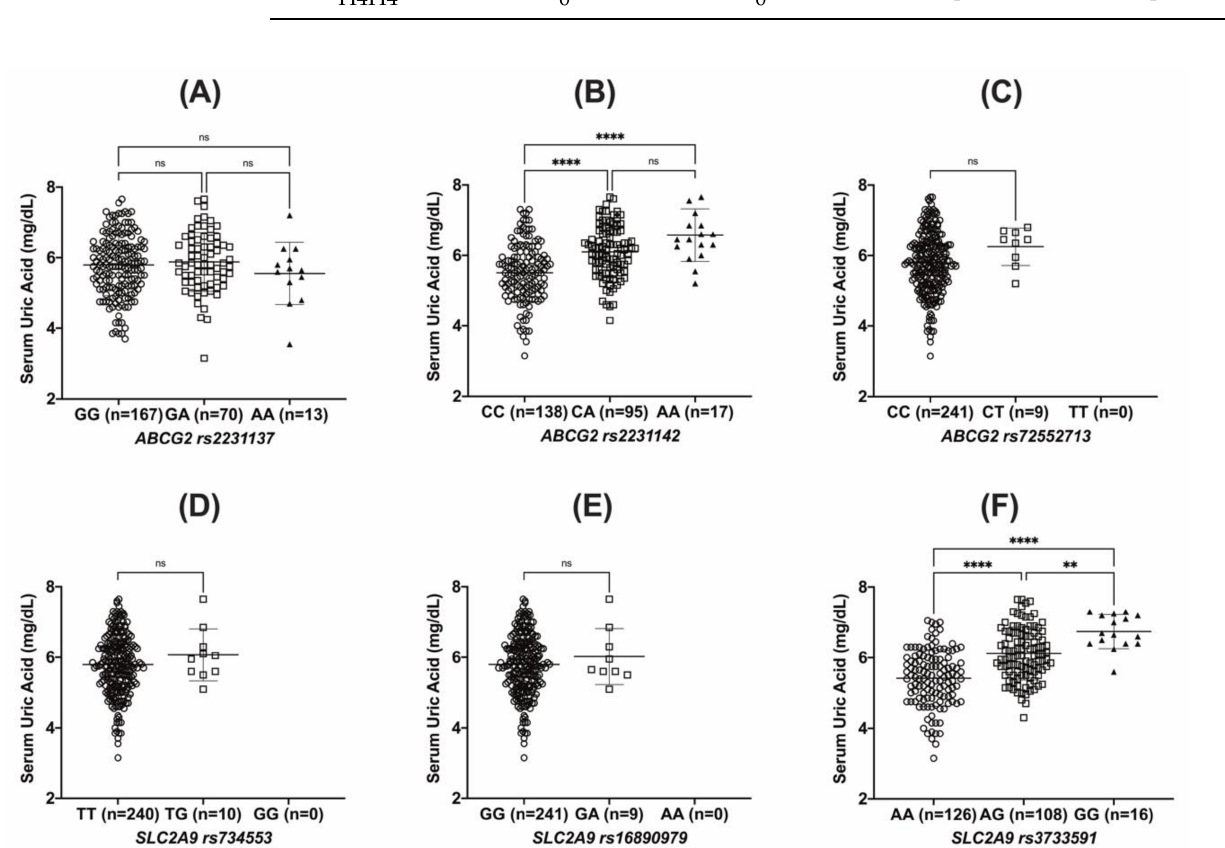
Figure 2. Comparisons between serum uric acid levels according to ABCG2 ( A – C ) and SLC2A9 ( D – F ) polymorphisms. The asterisks indicate the significant differences of groups (**, p < 0.01; ****, p < 0.0001, circle: homozygote wildtype, rectangle: heterozygote mutant, triangle: homozygote